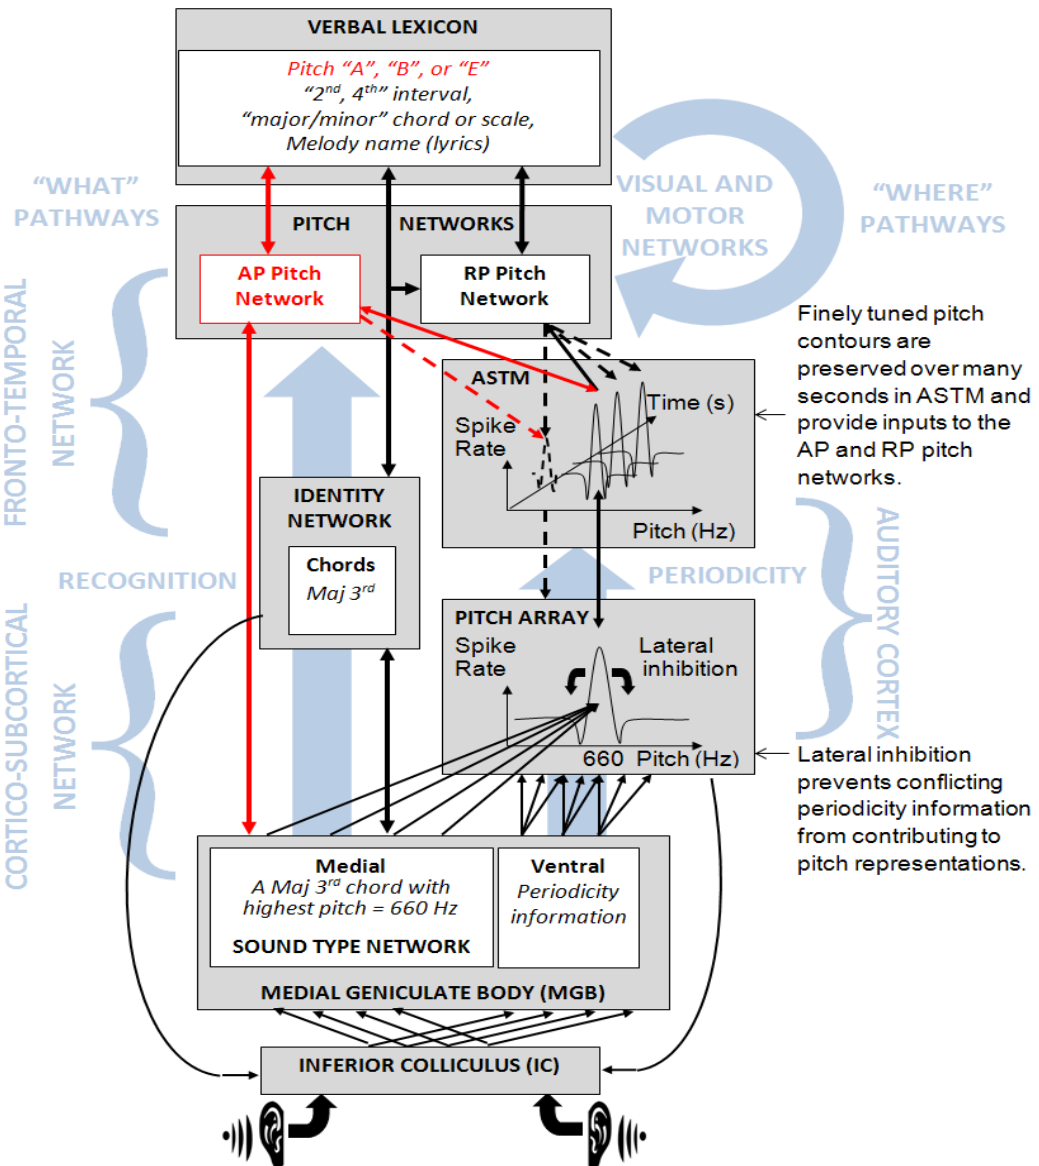
Figure 5. The dual mechanism model of AP in the context of concurrent pitch processing. Recognition mechanisms that involve the sound type and identity networks including verbal labeling are shown on the left of the figure. Periodicity processing through the auditory core is shown on the right. Spectral processing in the Inferior Colliculus (IC) provides inputs to the chord identity, RP ( black ) and AP ( red ) pitch networks, and the pitch array. Spectral recognition mechanisms prime one pitch of the chord in the pitch array, and chord identities prime pitch expectancies for the other pitches in auditory short-term memory (ASTM) ( dashed arrows ) via the RP pitch network. ASTM can also be directly primed by spectral recognition mechanisms in AP